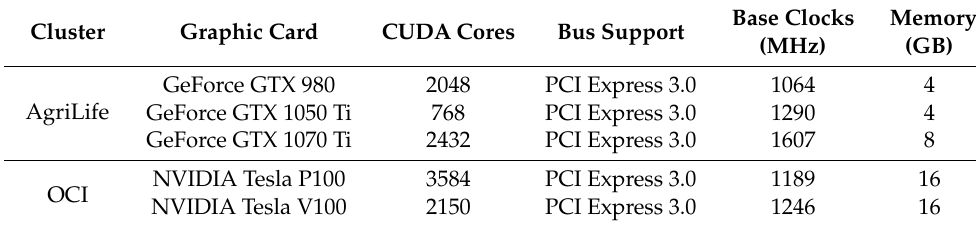
Table A2. Specifications of GPU of the nodes in the AgriLife and OCI.